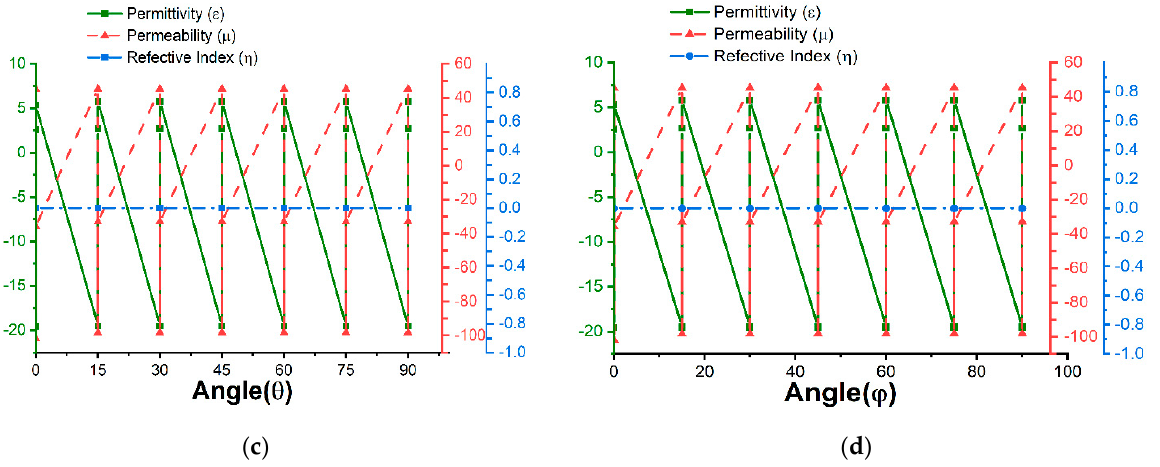
Figure 8. Roger4450B permittivity, permeability, and reflective index with respect to polarization angle θ and φ for ( a , b ) S 11 and ( c , d ) S 21 .